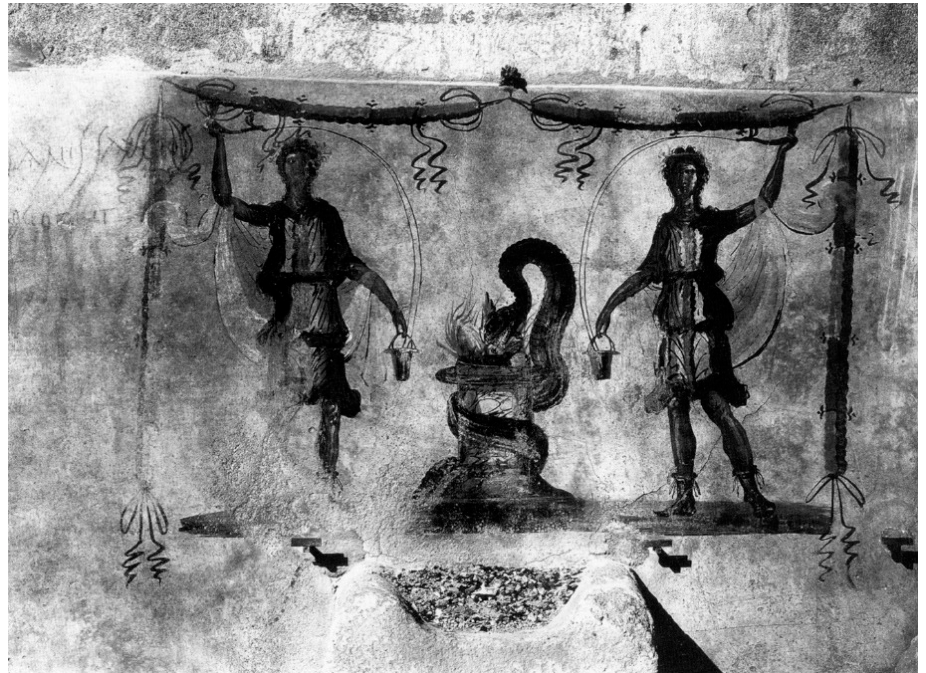
Figure 12. Façade associated with house number 1.11.1, Pompeii. Two lares flank a circular altar, with a snake. A masonry altar with offerings still atop at the bottom. (Modified by author, after Fröhlich 1991, Taf. 53.1).